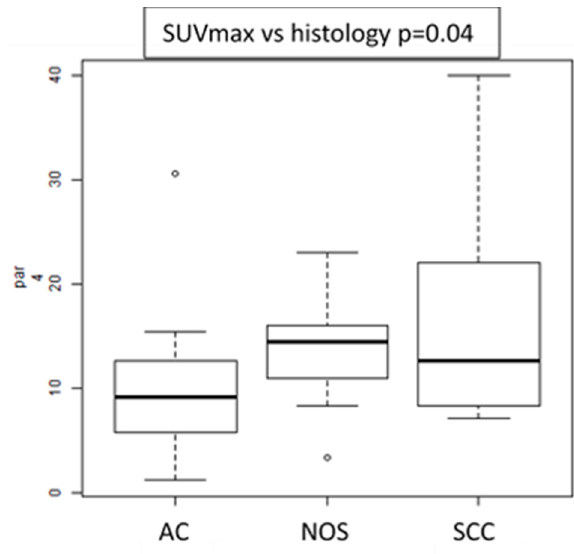
Figure 2. Box plot of SUVmax values showing differences between histological subtypes.